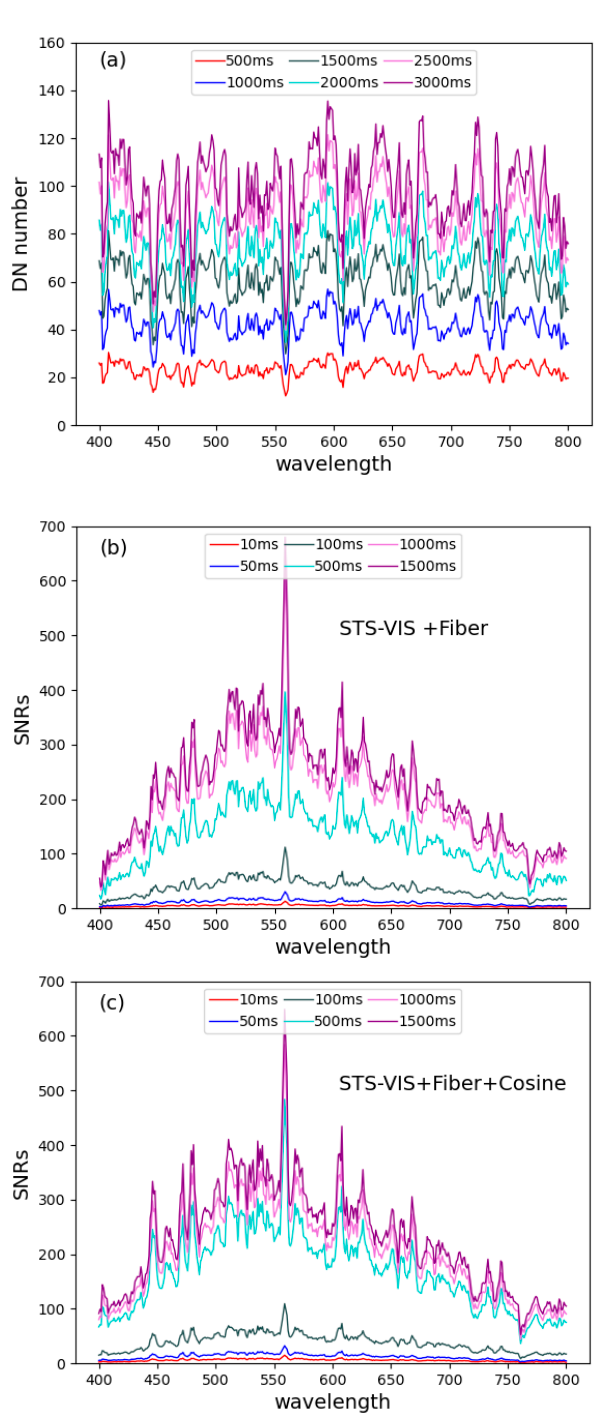
Figure 3. Dark current diagram for different integration times ( a ), SNR diagram for radiance measurement of DN values ( b ), SNR diagram for irradiance measurement of DN values ( c ).